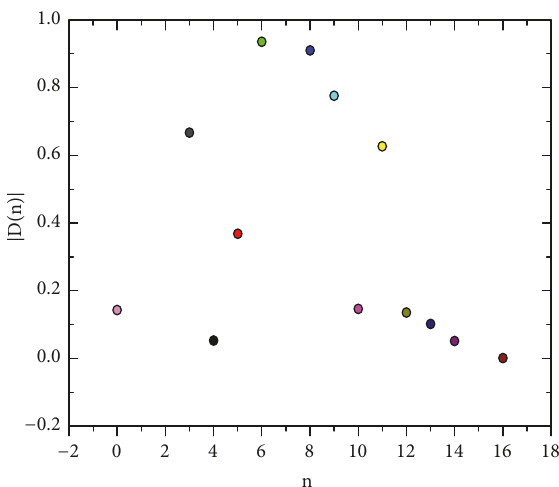
Figure 2: The absolute contributions of the vacuum condensates with dimension 𝑛 in the operator product